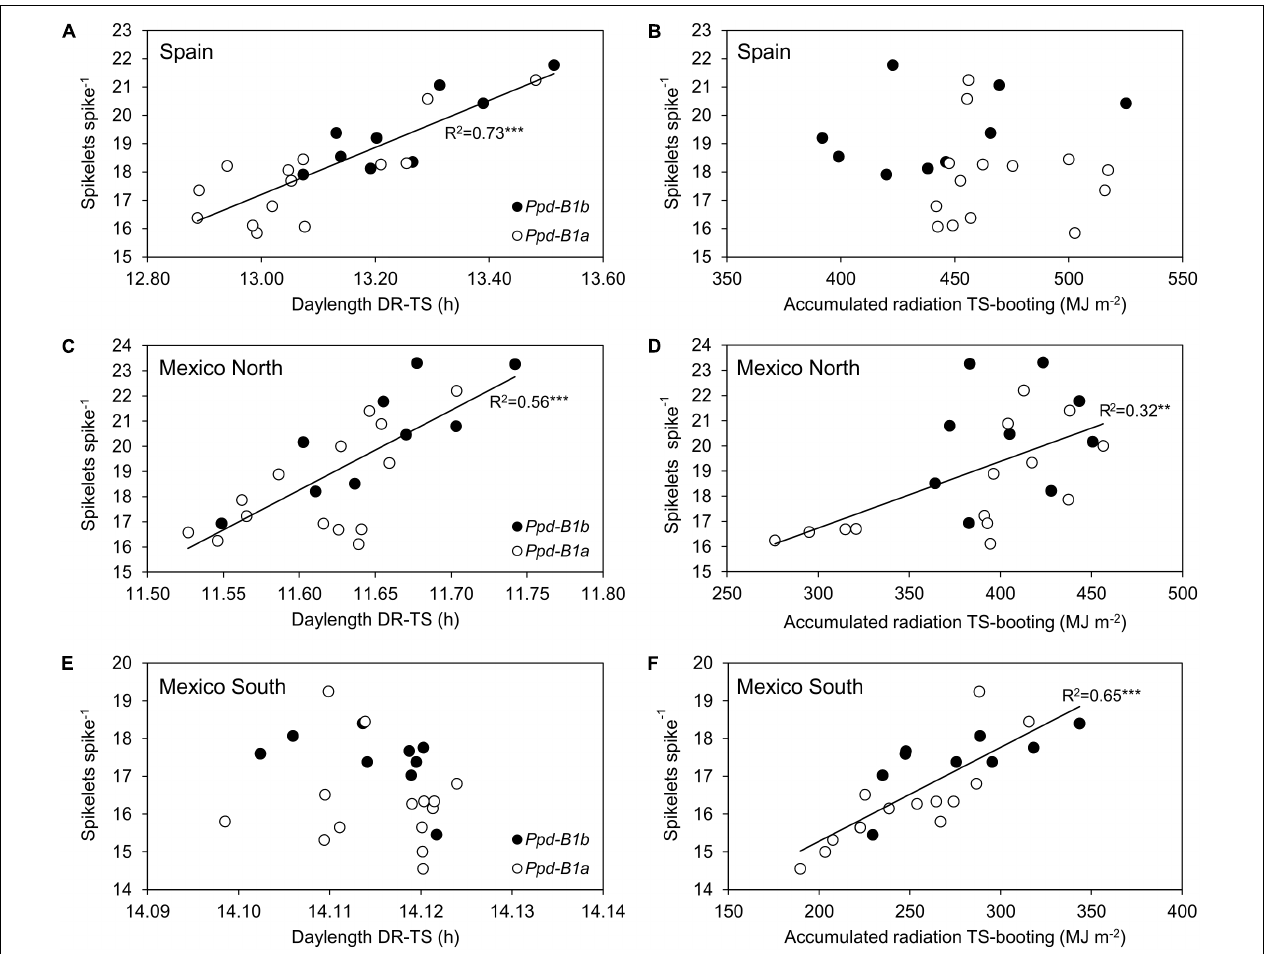
FIGURE 4 | Relationship between mean daylength (h) from double ridge to terminal spikelet (A,C,E) and accumulated solar radiation (MJ m − 2 ) from terminal spikelet to booting (B,D,F) and spikelets spike − 1 for the 23 durum wheat genotypes carrying the Ppd-B1a ( ◦ ) and Ppd-B1b ( • ) alleles, for each site across 3 years.